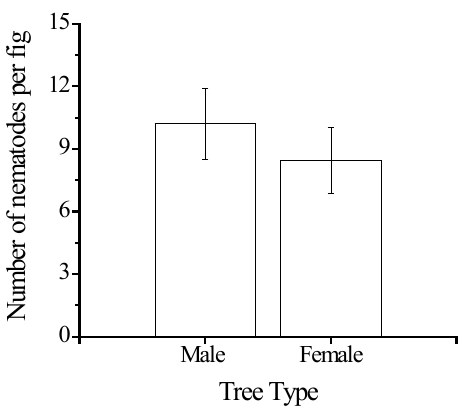
5 of 11 Figure 1. Diagnostic features of adults of nematodes species found inside male and female figs of Ficus hispida . Adults of Ficophagus cf. centerae ( a ) Martininema baculum ( b ) and Caenorhabditis sp ( c ) showing their specific mouthparts. Bars represent 20 μm for ( a , b ) and 50 μm for ( c ). A sub-sample of smaller figs that foundresses had only recently entered (B phase) contained only pre-adult or juvenile stages of the three nematodes. Recently dead fig wasps in these figs often had one or two nematodes still present on or near them (22 of 30 male figs and 17 of 30 female figs collected from three trees of each sex). However, most